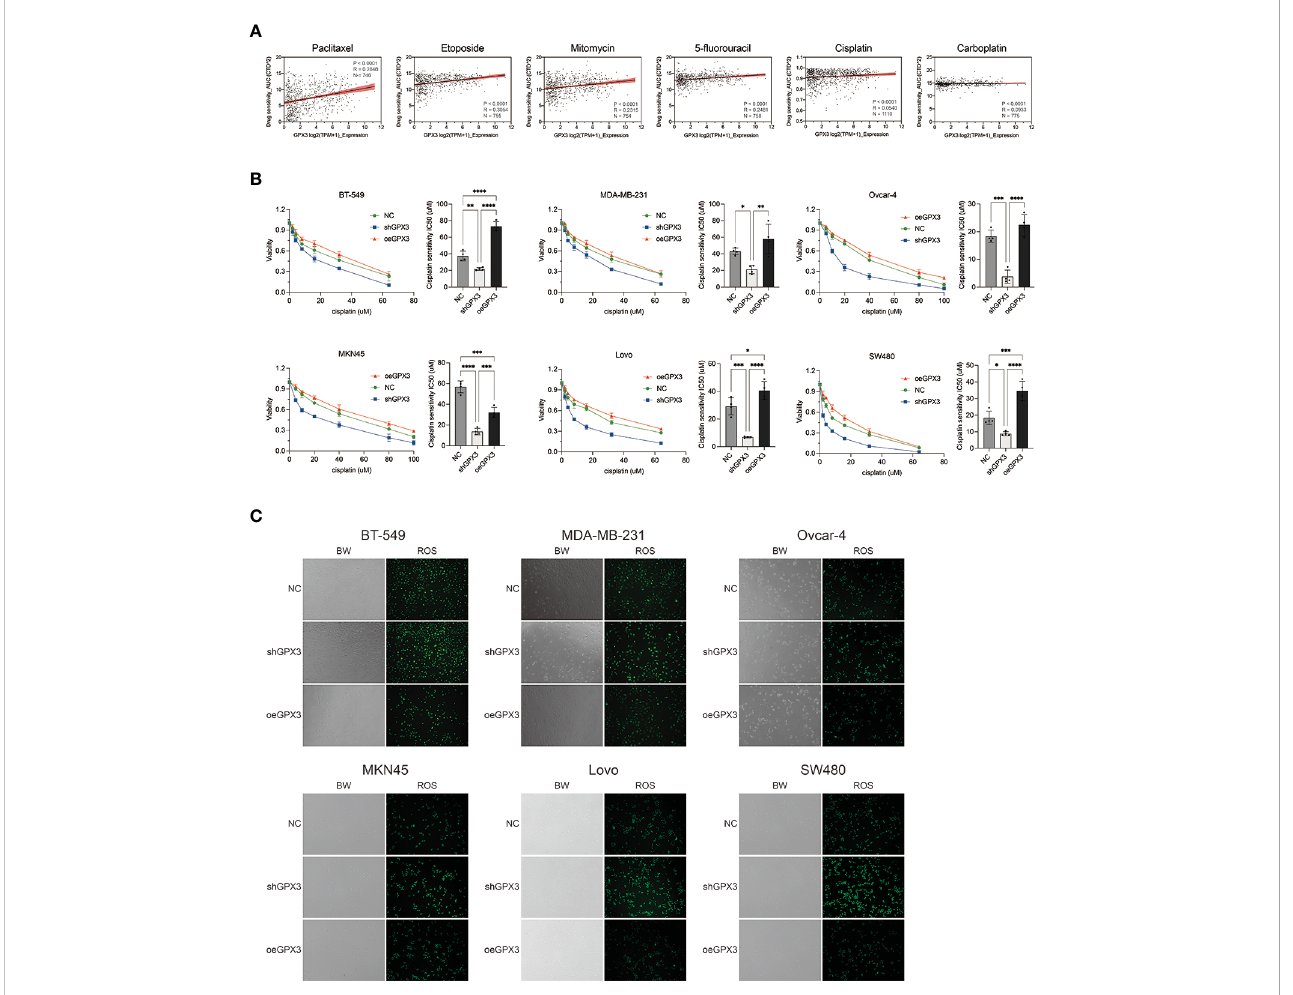
FIGURE 9 Knockdown GPX3 increased human cancer cell ’ s sensitivity to cisplatin. (A) Expression of GPX3 was positively correlated to IC50 of chemotherapy drugs, including paclitaxel, etoposide, mitomycin, 5- fl uorouracil, cisplatin, and carboplatin in pancancer. (B) Cell viability was assessed 24h following treatment with cisplatin by using cck-8 assay. (C) ROS in cells was assessed 4h following treatment with cisplatin by using DCFH-DA probe. *(p<0.05), **(p<0.01), ***(p<0.001),